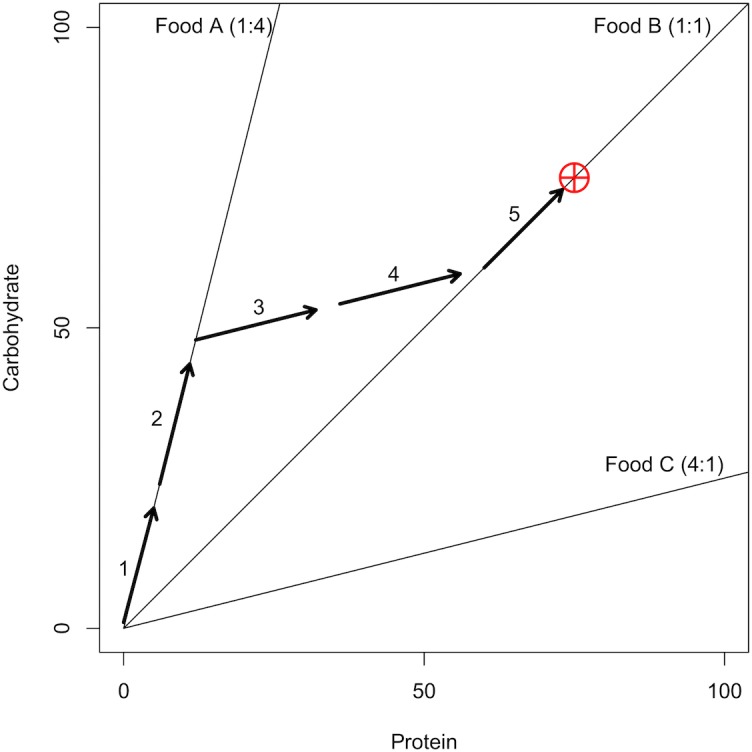
An Example of the Geometric Framework (GF).A visualisation of the GF [23] used to track the nutritional state of a hypothetical individual. The graph area depicts the nutrient space available with two macronutrients; protein (P) is represented on the x-axis and carbohydrate (C) on the y-axis. The requirements of the individual with regards the two macronutrients are depicted by the Intake Target (IT; the red crosshair). In this instance the requirements for P and C are equal (75:75). An individual’s nutritional state is its (x, y) position in the nutrient space. The only way for an individual to move through the nutrient space to the IT is to eat foods. Three foods with differing P:C ratios are depicted by three food rails (solid black lines); Food A is high in C but low in P (P:C, 1:4); Food B is balanced (1:1); Food C is high in P but low in C (4:1). As an individual eats, its nutritional state moves through the nutrient space (depicted by the sequence of arrows) in parallel to the food rail for the food it is eating. Here, the individual has reached the IT by first eating Food A for steps one and two, then Food C for steps three and four, and finally on Food B for the step five. The individual could also have taken a more direct route to the IT by eating only Food B. This food is nutritionally balanced in regard to the individual’s IT. Alternatively, the individual may have eaten equal amounts of macronutrient from Foods C and A. These two foods are individually imbalanced but collectively complementary.